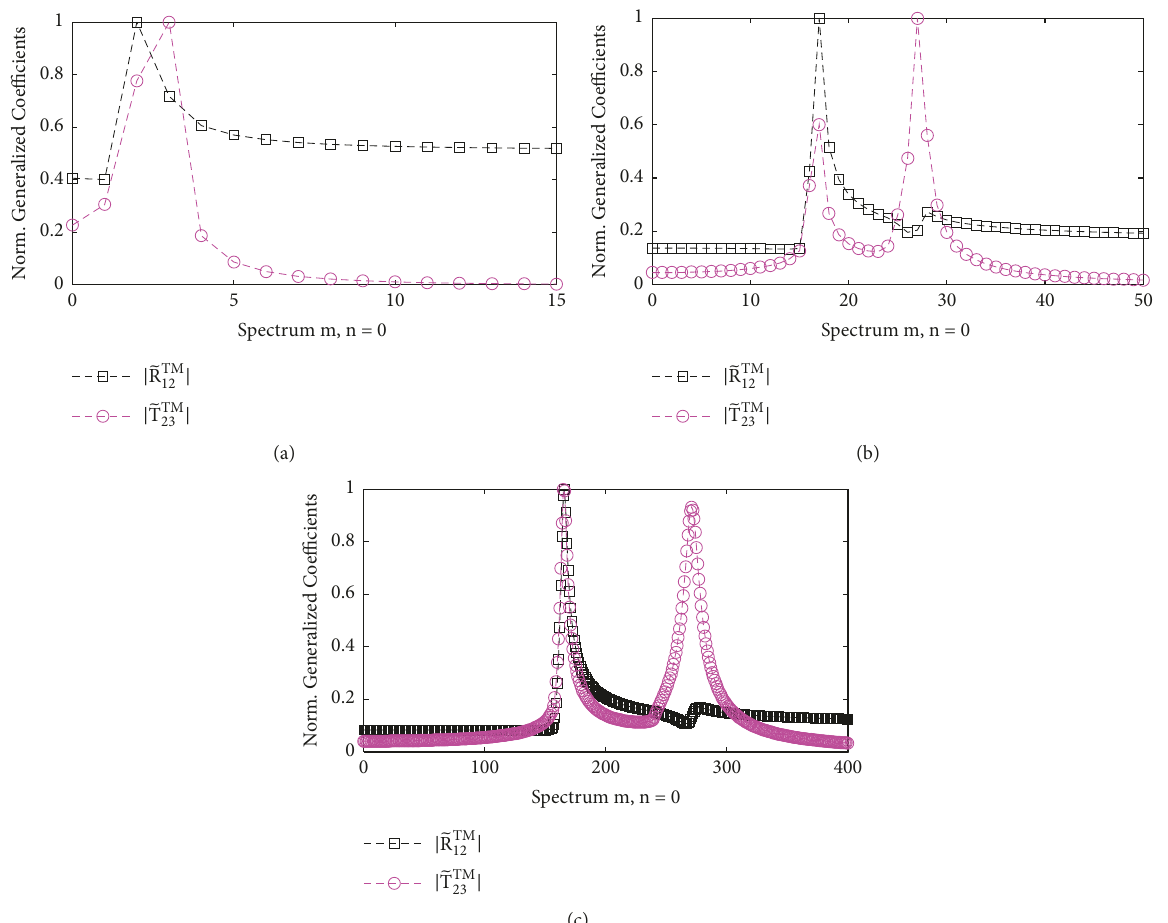
= 1𝜇𝑚 ; (b) Δ = 10𝜇𝑚 ; (c) Δ = 100𝜇𝑚 . In these 𝑐 𝑐 𝑐